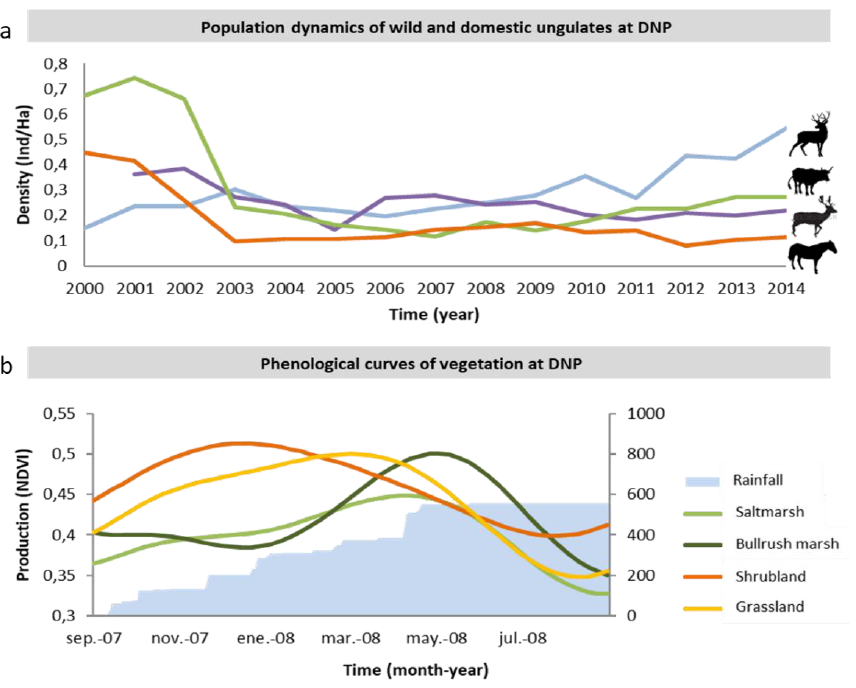
Figure 2. ( a ) Evolution of the population density (individuals/ha) of the four species of ungulates present at Doñana National Park area during the study period. ( b ) Phenological curves of the four vegetation types during 2007–2008, a hydro-meteorological year whose levels of accumulated rainfall (blue bars) coincide with the average of the study period (2000–2014). Phenological curves were fitted to MODIS NDVI values aggregated per vegetation type (all management units merged), using the TIMESAT software.